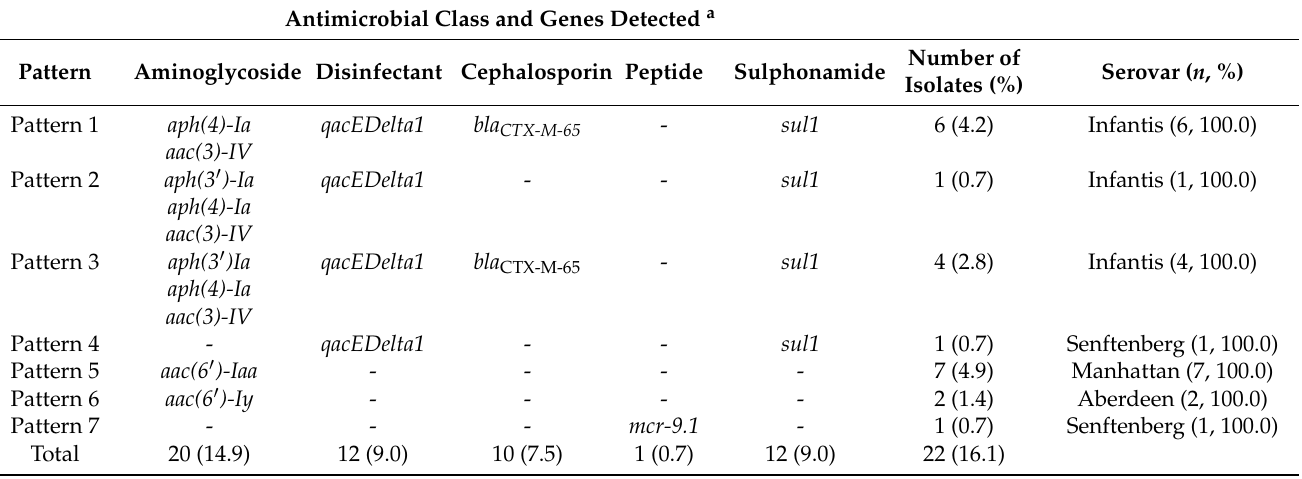
Table 2. Antimicrobial class and genes detected in 146 Salmonella isolates were used in this study. Antimicrobial Class and Genes Detected a